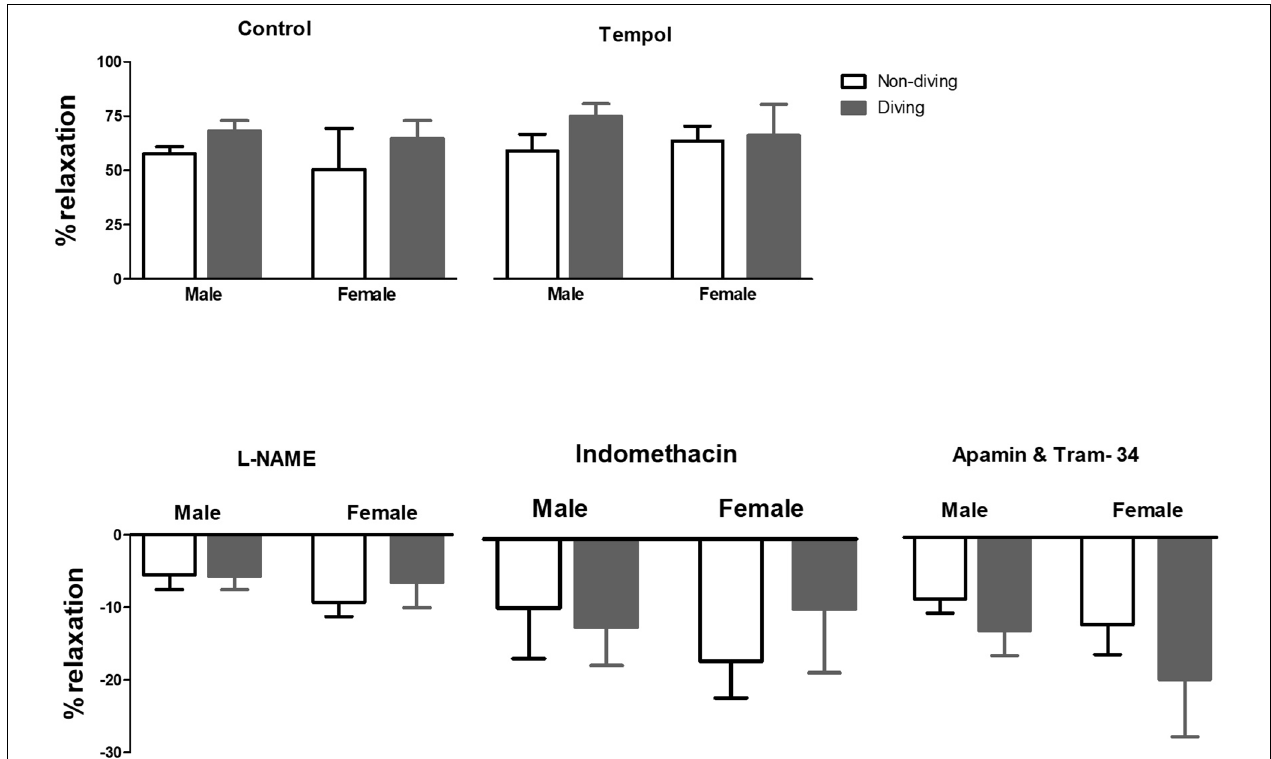
FIGURE 4 | Percentage of relaxation in pulmonary arteries of ApoE KO rats in response to 10–5 M concentration of ACh in the presence of inhibitors for different endothelium-dependent relaxing pathways, ANOVA, n = 5.